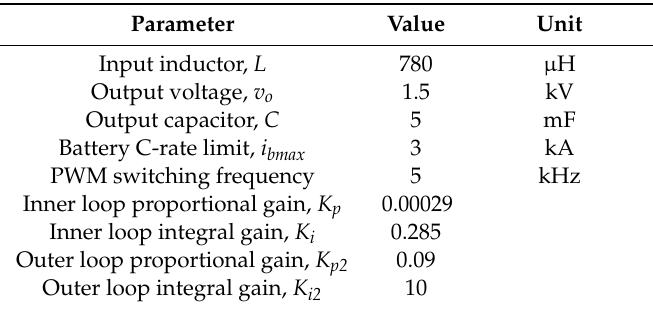
Figure 5. Unit step response of the inner and outer closed loop transfer functions of the DC/DC boost converter control system. Table 4. DC/DC converter parameters.